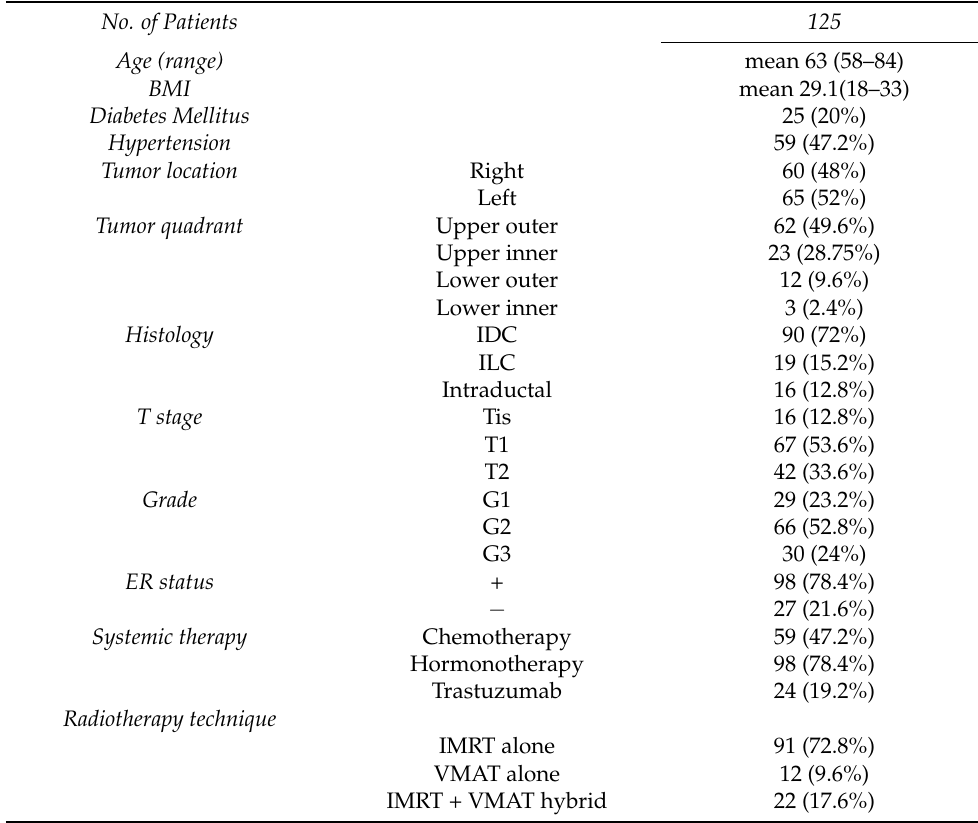
Table 1. Patient